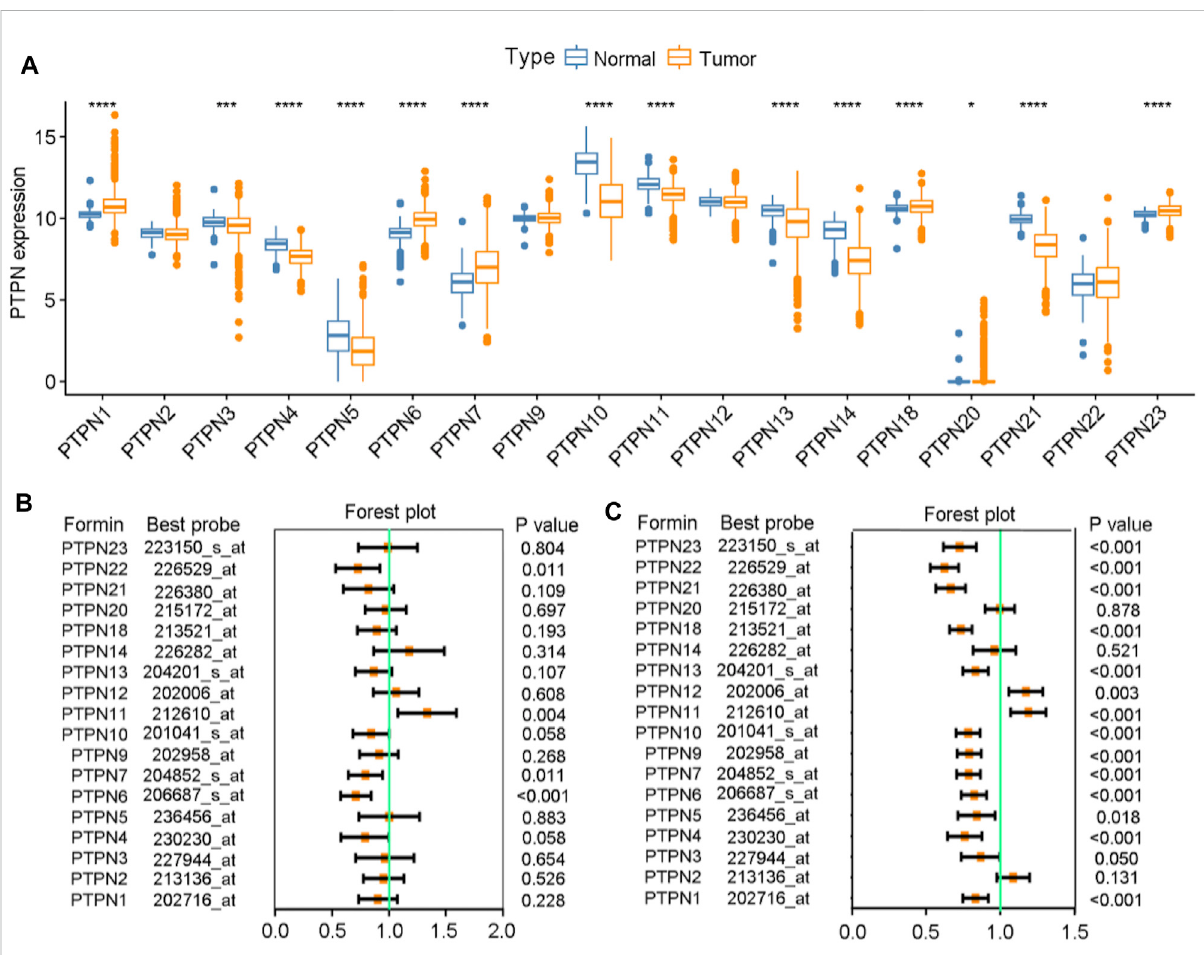
FIGURE 1 Expression levels and prognostic values of PTPNs in BrCa. (A) Expression levels of PTPNs genes in the normal and tumor groups. (B) Forest plot displaying the prognostic values of PTPNs for OS generated by using the Kaplan-Meier plotter database. (C) Forest plot displaying the prognostic values of PTPNs for RFS generated by using the Kaplan-Meier plotter